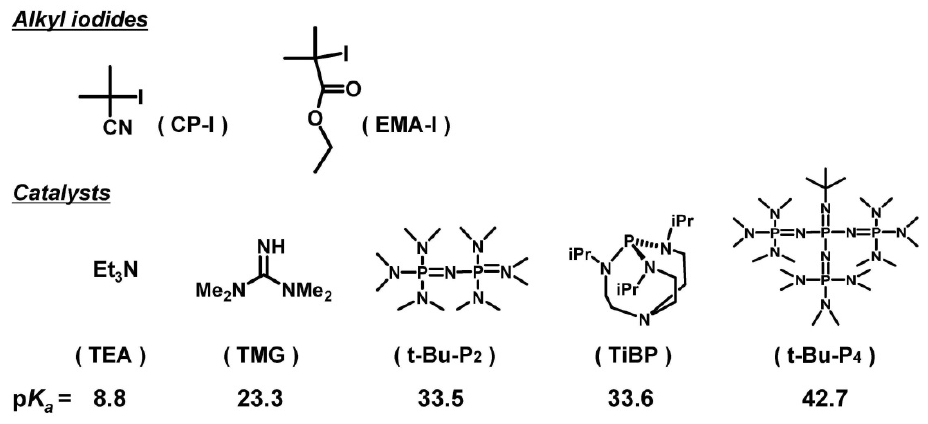
Figure 1. Structures of alkyl iodides and catalysts used in this